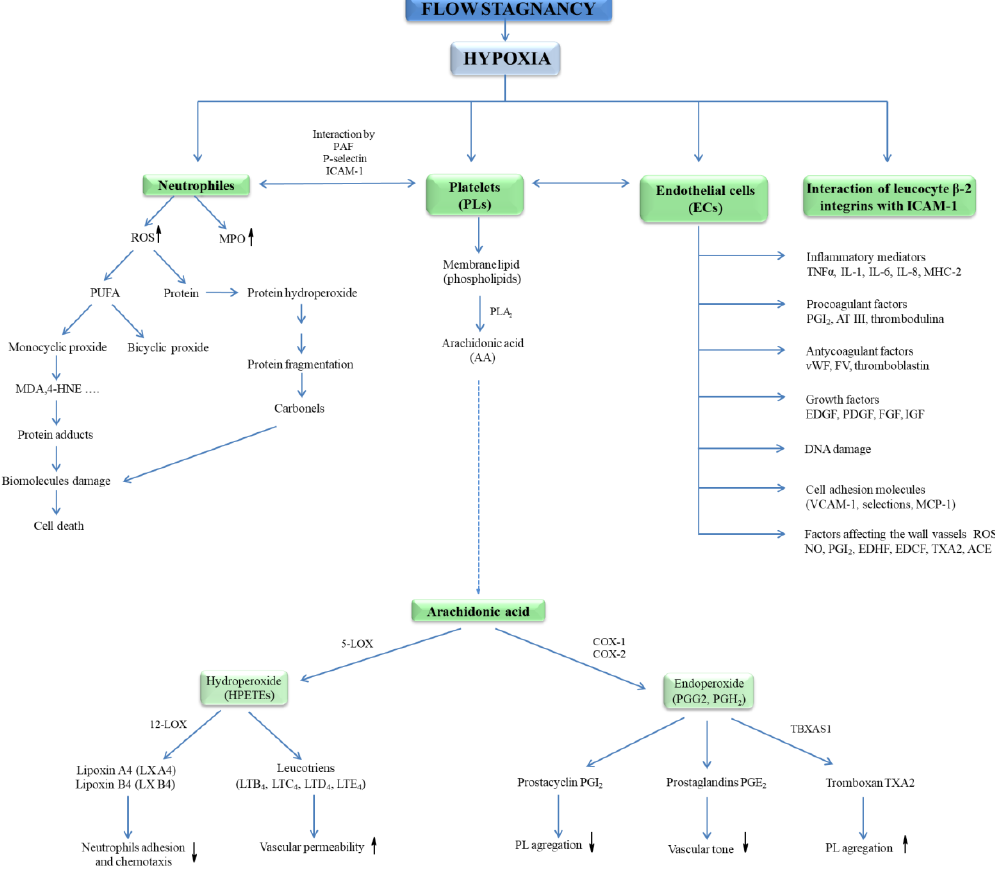
Figure 2. Neutrophils, platelets, and endothelial cells interactions in hypoxia lead to blood cell response. Activation of neutrophils causes a respiratory burst and an increase in myeloperoxidase (MPO) activity. Release of ROS initiates the oxidation of proteins, lipids, and DNA. In contrast, activation of ECs leads to the secretion of procoagulant factors (PGI, AT III, thrombomodulin), growth factors (EDGF, FGF, IGF, PDGF), inflammatory mediators (IL-1, IL-6, IL-8, TNF- α , MHCII), factors regulating vascular wall tension (ROS, NO • , PGI2, EDHF, ACE, TXA2, EDCF) as well as release of anticoagulant agents (vWF, FV, thromboplastin), endothelial cell-adhesion molecules (VCAM-1, selectins, MCP-1). In turn, activation of blood platelets leads to the release of PGG2, PGH2, TXA2. Abbreviation: angiotensin-converting enzyme (ACE), antithrombin III – (AT III), deoxyribonucleic acid (DNA), endothelial cells (ECs), endothelium-derived contracting factor (EDCF), endothelium-derived growth factor (EDGF), endothelium-derived hyperpolarizing factor (EDHF), fibroblast growth factor (FGF), insulin-like growth factor (IGF), interleukin (IL), monocyte chemoattractant